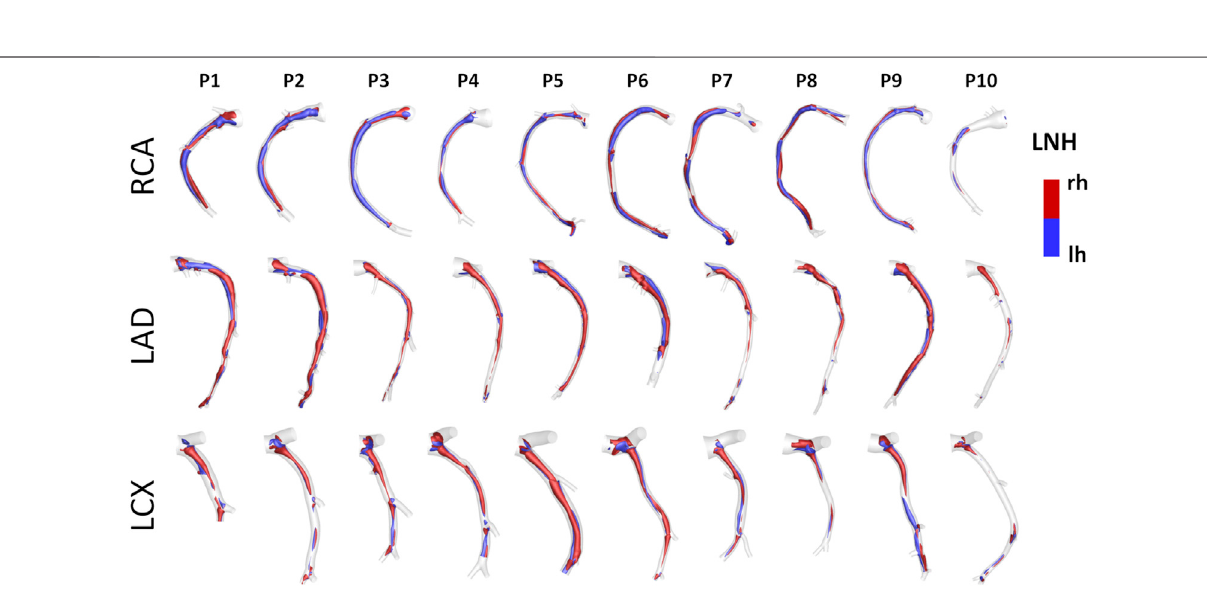
Frontiers in Bioengineering and Biotechnology |